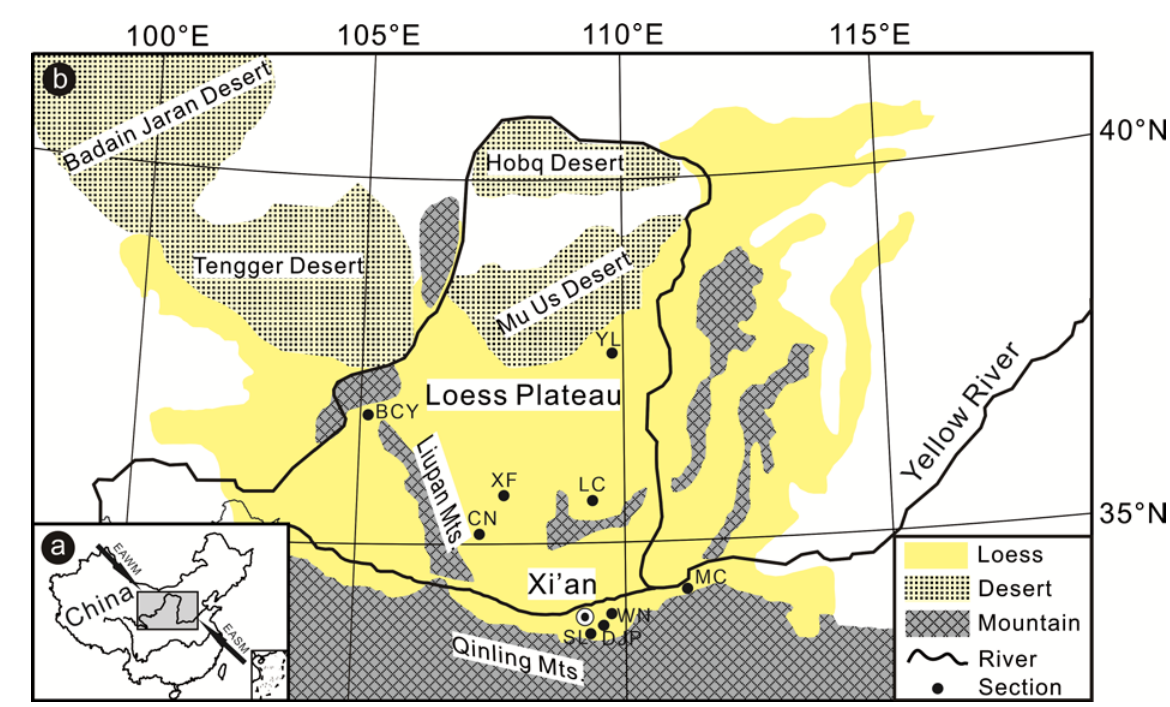
Figure 1. Map showing location of loess sections (black spot) ( a ) on Chinese Loess Plateau ( b ). YL: Yulin; BCY: Baicaoyuan; XF: Xifeng; LC: Luochuan; CN: Chaona; MC: Mianchi; WN: Weinan; DJP: Duanjiapo; SL: Shaoling; EASM: East Asian summer monsoon; EAWM: East Asian winter monsoon.